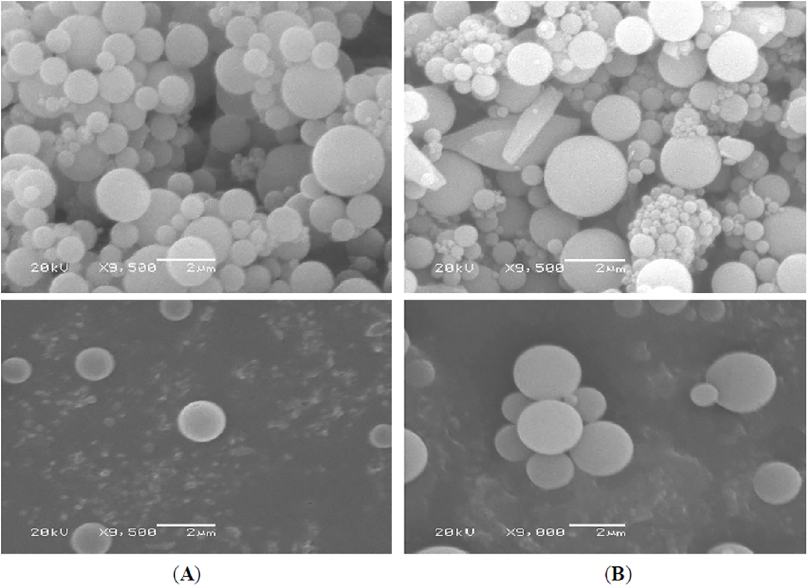
Fig 11. Scanning electron micrographs of (A) Free microspheres and (B) 7e-LoadedPLGA microspheres.